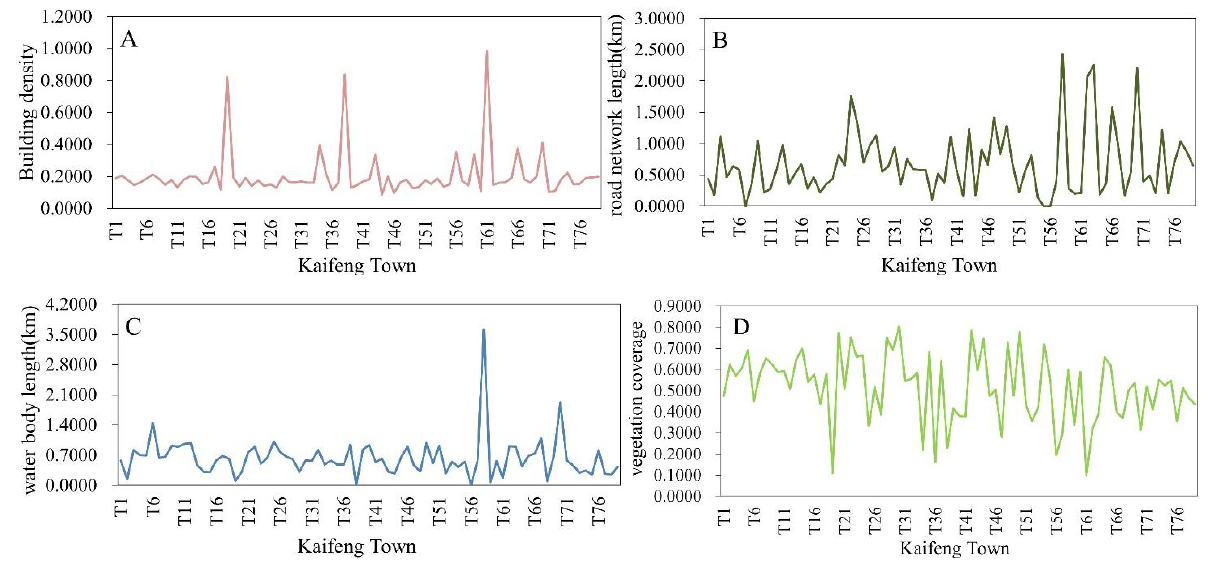
Figure 6. ( A ): Building density of each township in Kaifeng; ( B ): the road network length of each township in Kaifeng; ( C ): the length of the water body in each township of Kaifeng; ( D ): vegetation coverage of towns and villages in Kaifeng.